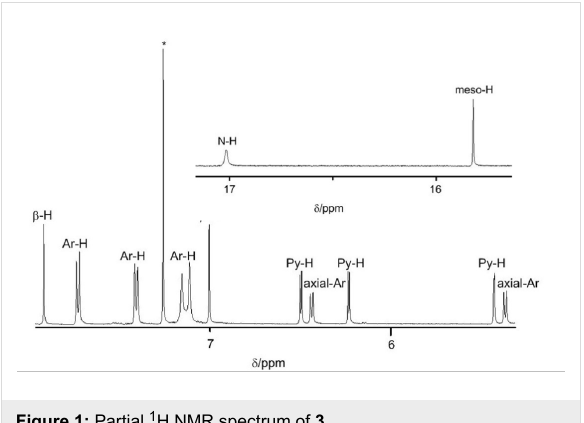
Figure 1: Partial 1 H NMR spectrum of 3